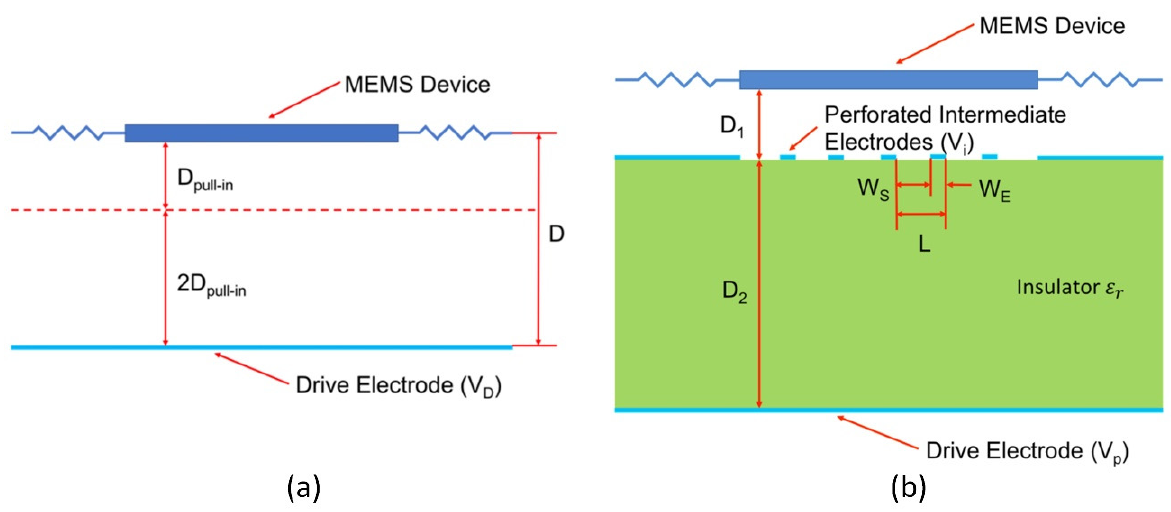
Figure 6. Comparison of electrostatic actuators: ( a ) conventional electrostatic actuator; ( b ) new topology with perforated intermediate electrode, D pull-in —controllable stroke, L—electrode pitch, W s —space between electrodes, W e —electrode width. Adapted from [73].